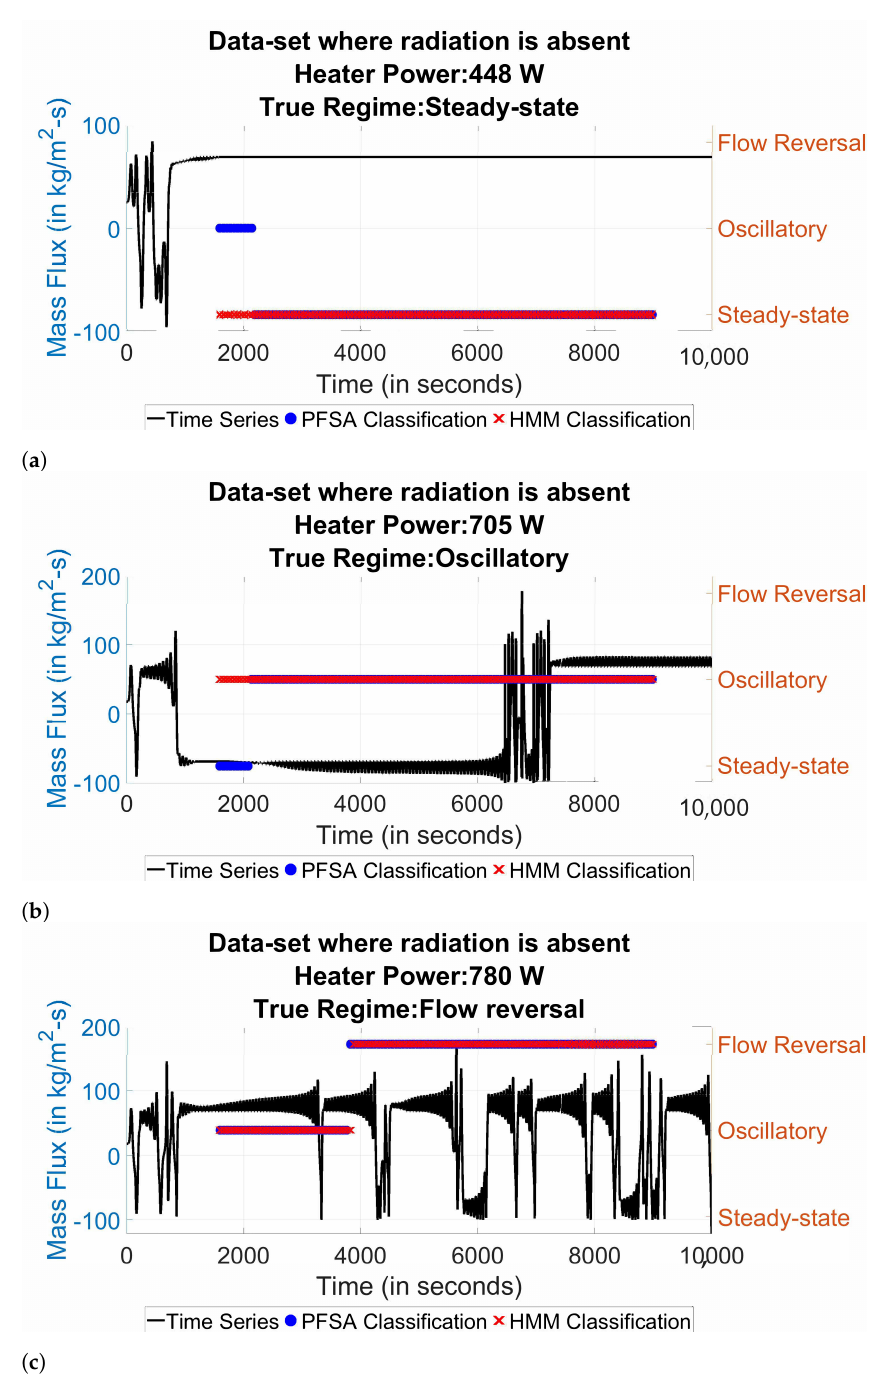
Figure 8. Transient classification for time-series in absence of radiation heat loss using PFSA and HMM for regimes of: ( a ) Steady-state, ( b ) Oscillatory, and ( c )